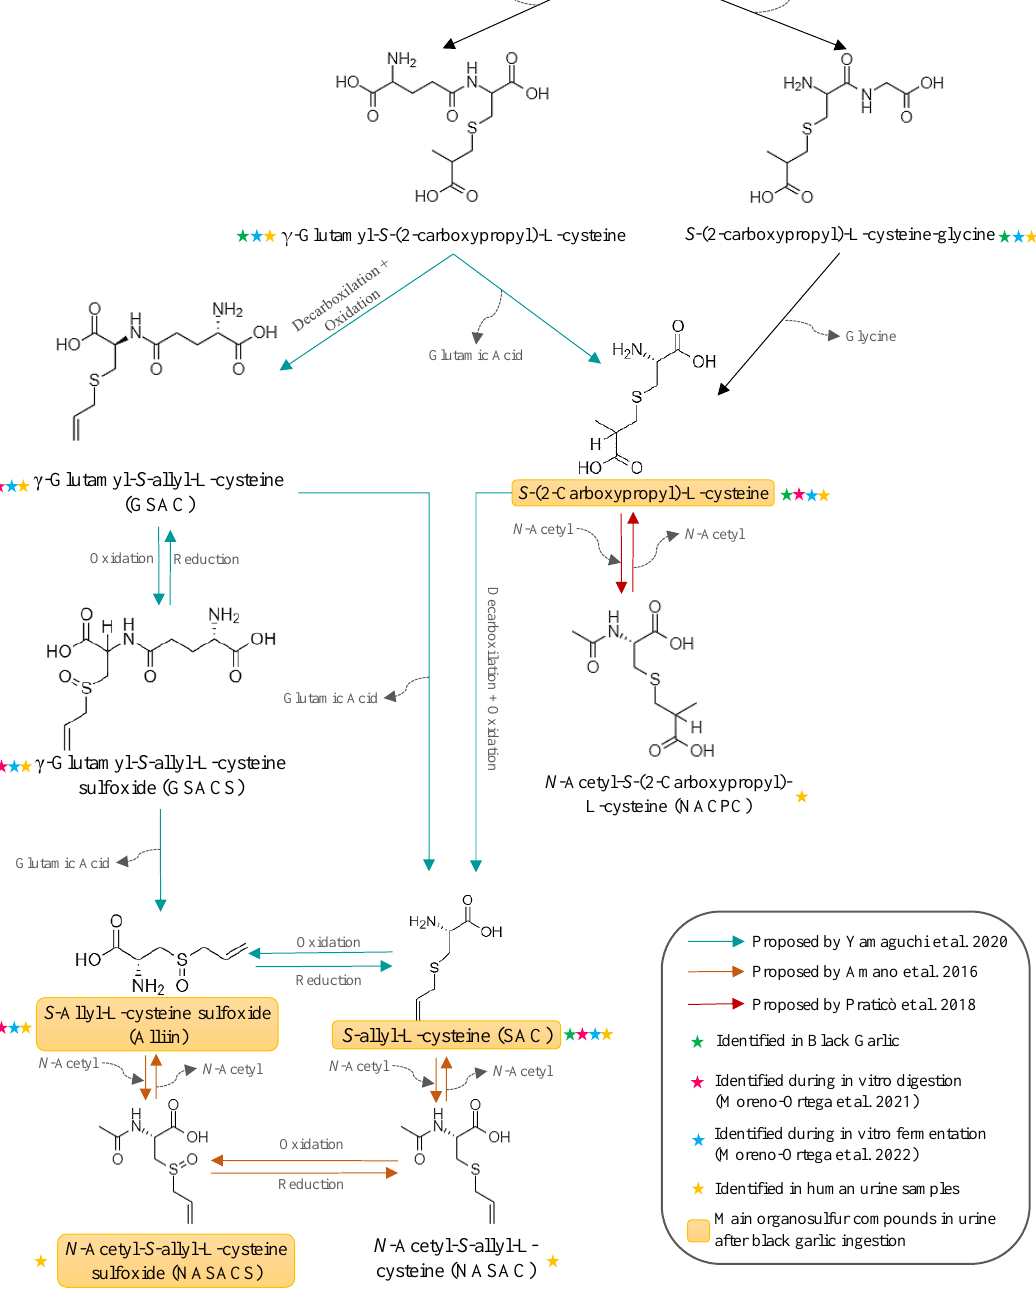
Figure 3. Potential pathway for the metabolism of γ-glutamyl- S -(2-carboxypropyl)-L-cysteine-glycine in the gastrointestinal tract after black garlic consumption. The proposed metabolism is in keeping with the findings of Yamaguchi et al., 2020, Amano et al., 2015 and Praticò et al., 2018, who monitored the metabolism of SAC in animal species. Boxed compounds indicate the main components excreted in urine after black garlic intake [40,46,47].